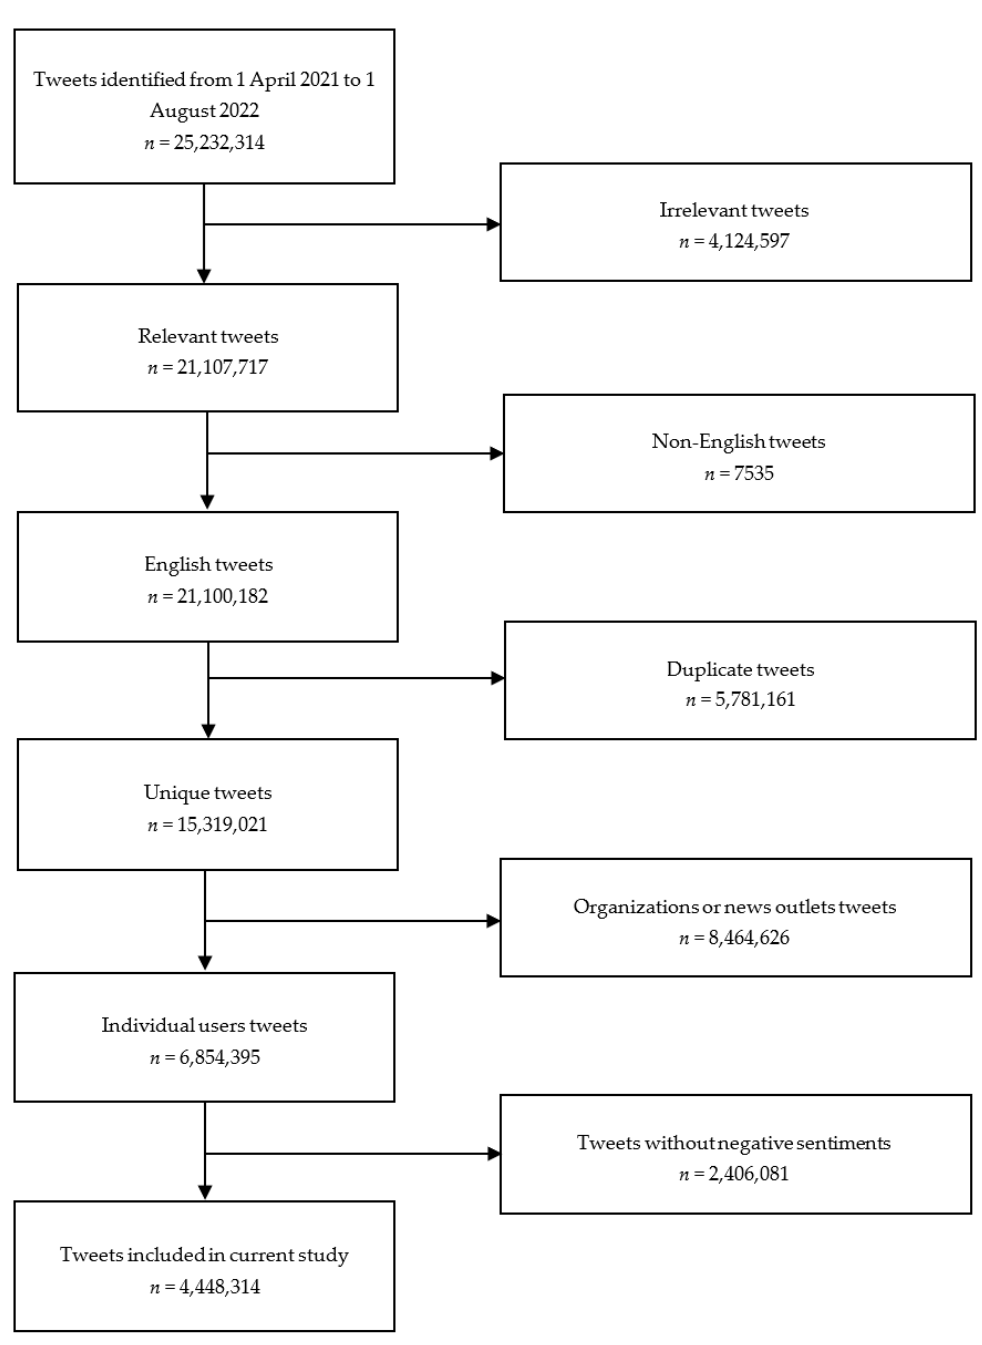
Figure 2. Flowchart illustrating tweet selection process.